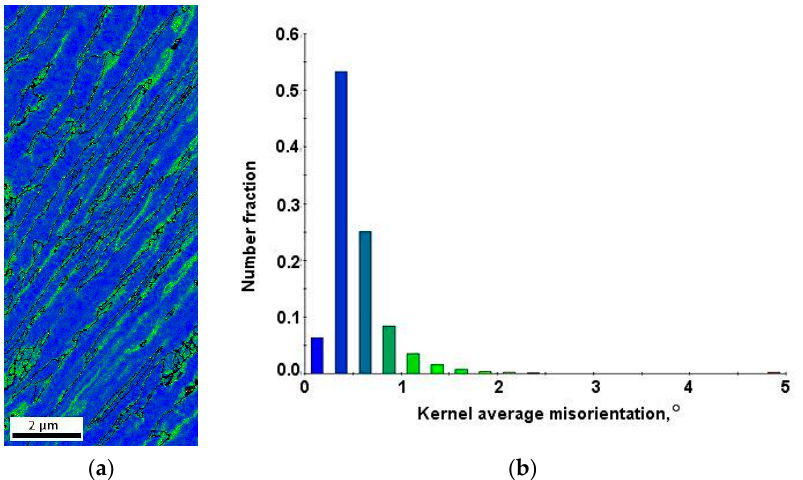
Figure 4. Color-coded kernel average misorientation map displaying the local strain distribution in the specimen in the initial state ( a ) and kernel average misorientation distribution ( b ).